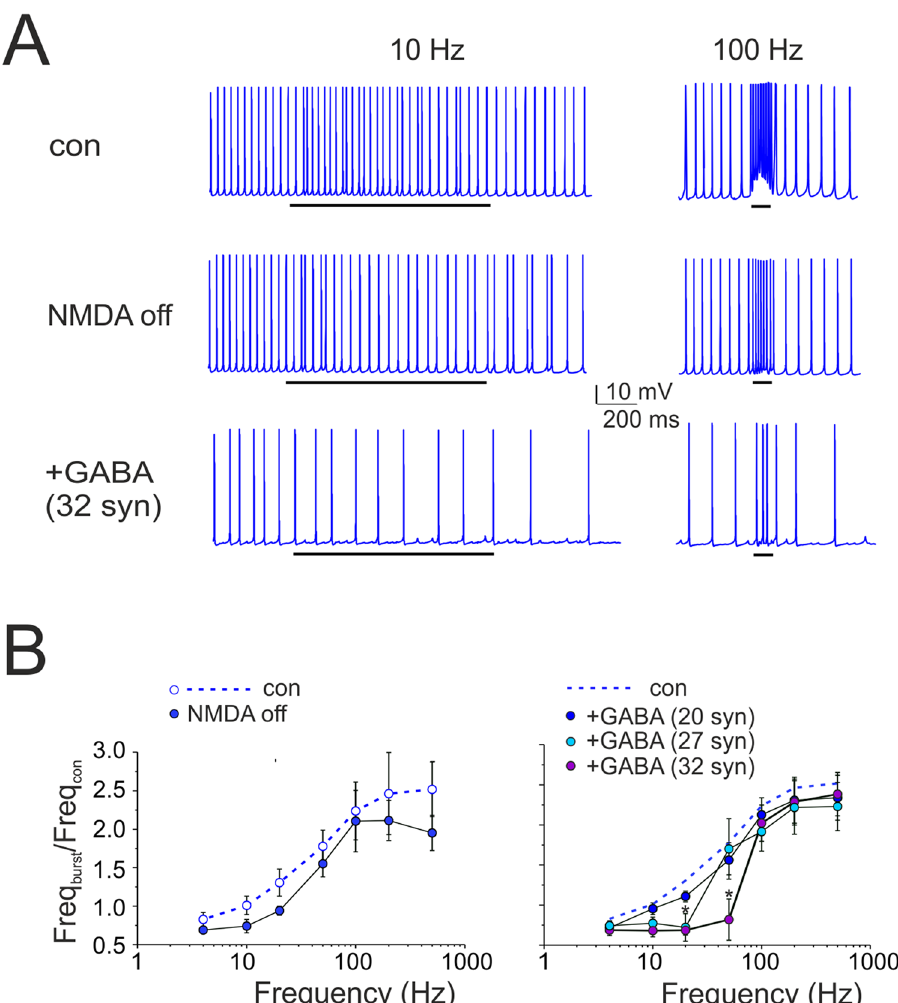
Figure 7. Regulation of SC gain function by NMDA and GABA A receptors. (A) The traces show simulated SC response to 10 pulses @ 100 Hz-delivered to PFs. NMDA receptor switch-off and activation of inhibitory (32) synapses activated simultaneously with the PF burst reduced SC firing rate. Black bar indicates the stimulus duration. (B) Input/output SC gain regulation. Note that the NMDA current block reduced the spike output frequency mostly during high-frequency bursts (200–500 Hz), while a sufficient number of inhibitory synapses (activated simultaneously with PF bursts) shifted SC excitation toward higher input frequencies. Data are reported as mean ± SEM (n =